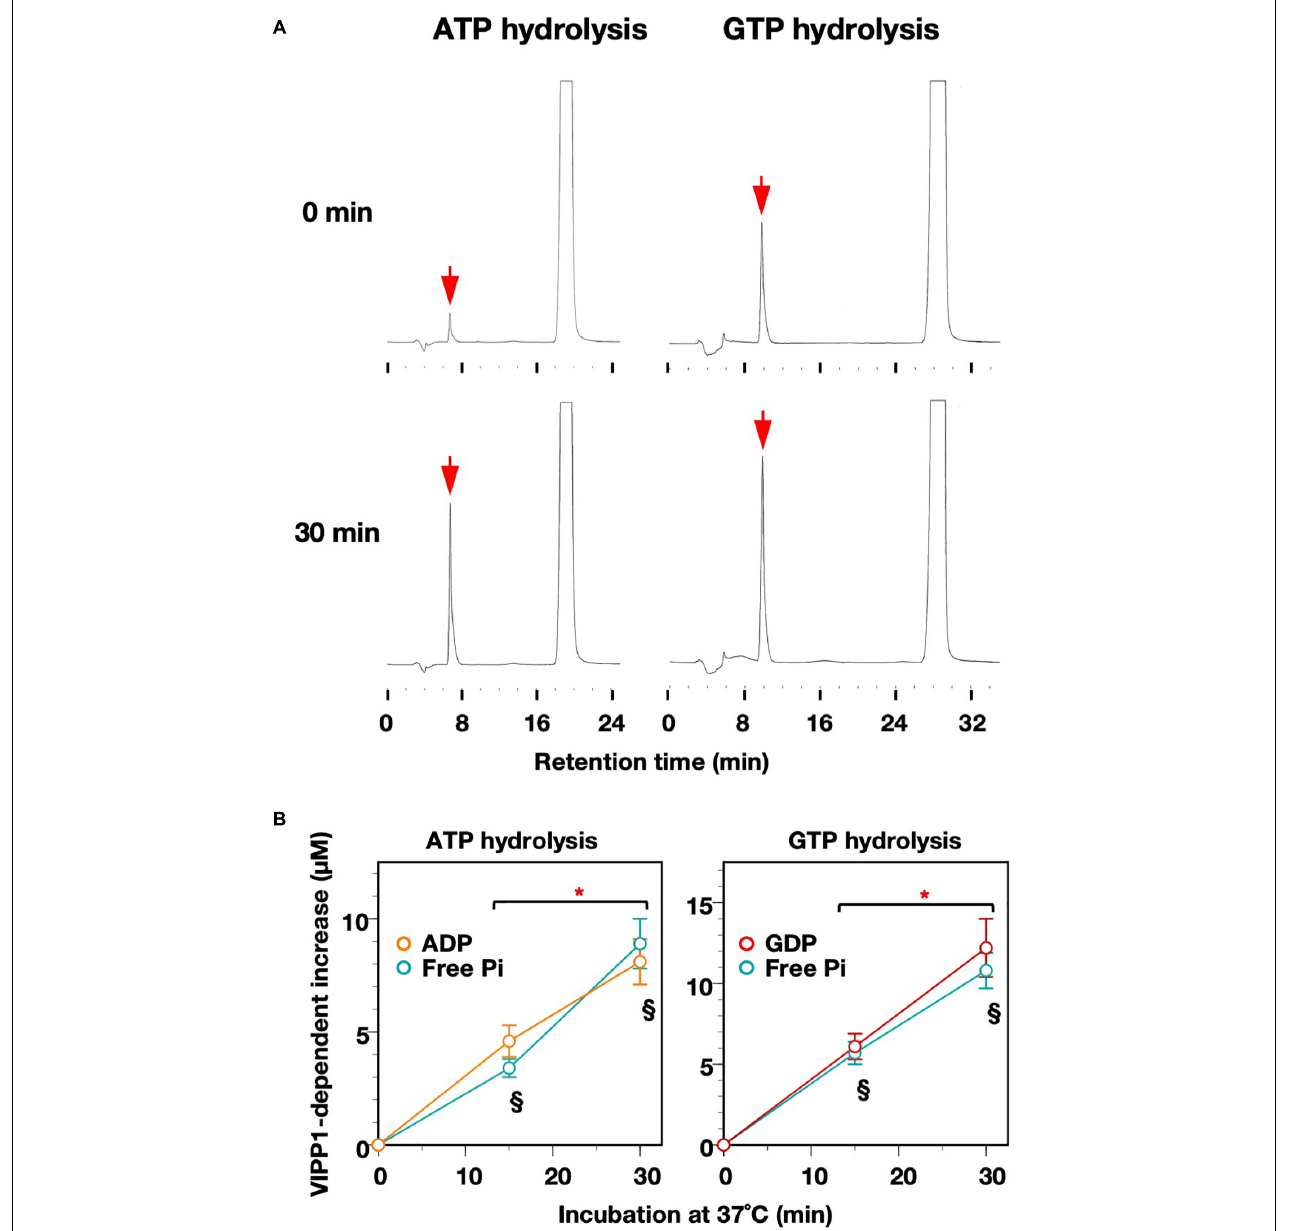
FIGURE 2 | Time-dependent increase in ADP/GDP and Pi. (A) Representative elution profiles obtained from the reaction mixtures after ATP- and GTP-hydrolysis. To obtain high enough signals to detect, the reactions were carried out with the addition of 2.5 µ g VIPP1-His protein instead of 1.0 µ g protein in standard conditions. The elution peaks corresponding to ADP (column for ATP hydrolysis) and GDP (column for GTP hydrolysis) are indicated with red arrows. (B) Time course graphs indicating increases in the levels of ADP and GDP, which were obtained by quantification of the results from HPLC analyses in panel (A) . The increase in level of Pi analyzed in the same conditions (using 2.5 µ g VIPP1-His protein) is also shown in the graphs. Asterisks indicate significant differences between the two time points according to a statistical analysis. § Under the data points denotes no significant difference between the concentration of ADP/GDP and that of free Pi at each time point (Welch’s t -test, p < 0.05). Error bars: ± SE.